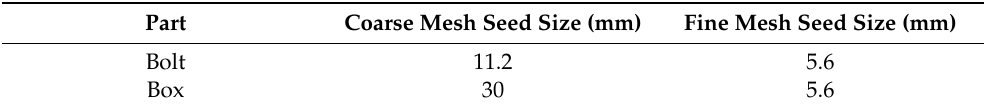
Table 7. Summary of seed